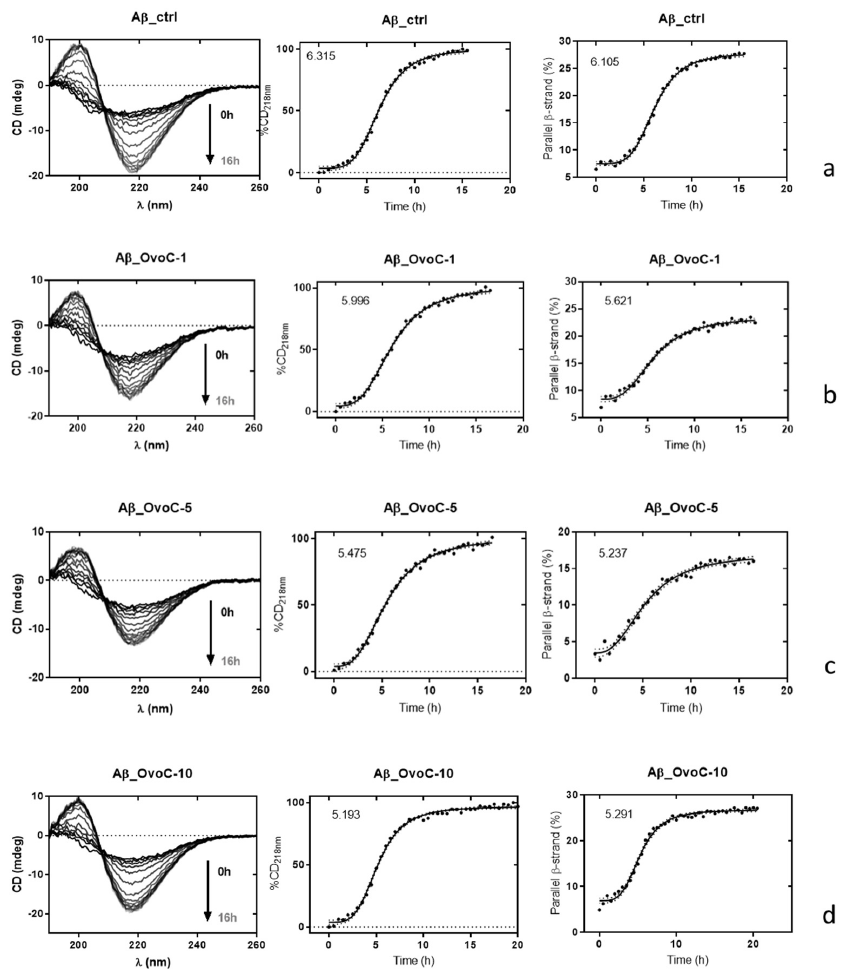
Figure 5. Circular dichroism spectra of amyloid β 42 (A β ) in the absence ( a ) and in the presence of ovocystatin at 1 µg/mL ( b ), 5 µg/mL ( c ), and 10 µg/mL ( d ) concentration. Ctrl—control; amyloid β alone—A β ; ovoC—ovocystatin; amyloid β 42 + ovocystatin: A β + ovoC. To determine if ovoC (10 and 100 µg/mL) and A β 42 affect PC12 cell viability, an MTT assay was performed. One-way ANOVA analysis revealed a 10% (OD 570 = 0.783) increase in PC12 cell proliferation of ovoC (10 µg/mL)-treated PC12 cells, while ovoC (100 µg/mL) showed an effect comparable to the control cells (OD 570 = 0.708) but is not toxic to cells (Figure 6a). A β 42 reduced PC12 cell viability to 85% (OD 570 = 0.608). To determine whether ovoC can inhibit A β 42-dependent toxicity, A β 42 (10µM) with and without ovoC (10 and 100 µg/mL) was added to PC12 cells for 24 h. An increase in PC12 cell viability was ob- served when A β 42 was applied together with ovoC. Cell survival increased to 105% for ovoC (10 µg/mL)(OD 570 = 0.743) and to 101% for ovoC (100 µg/mL)(OD 570 = 0.717) com- pared to cells treated with A β 42 alone (Figure 6b). Thus, this data indicate that ovocystatin increased the viability of A β 42-treated cells.